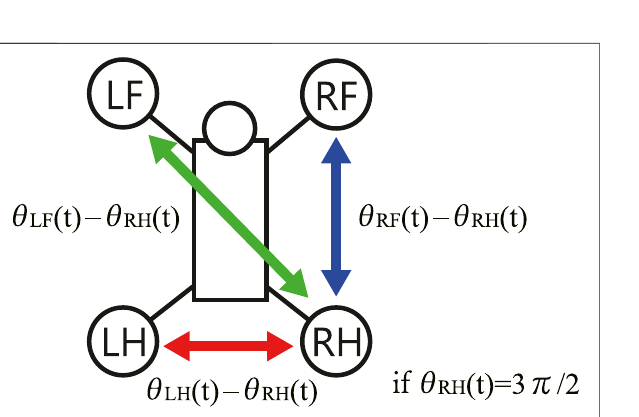
Frontiers in Robotics and AI |